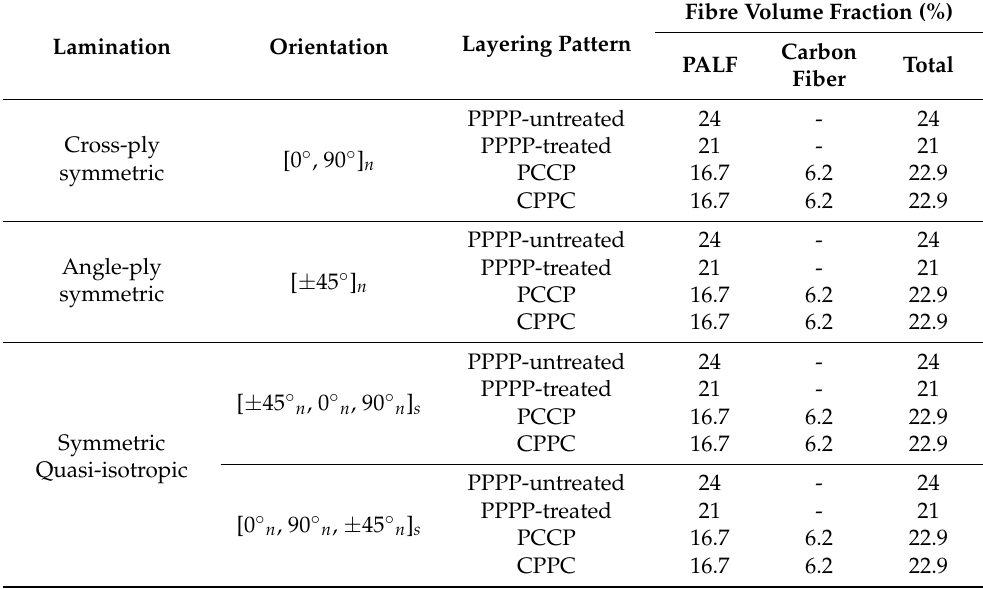
Fibre Volume Fraction